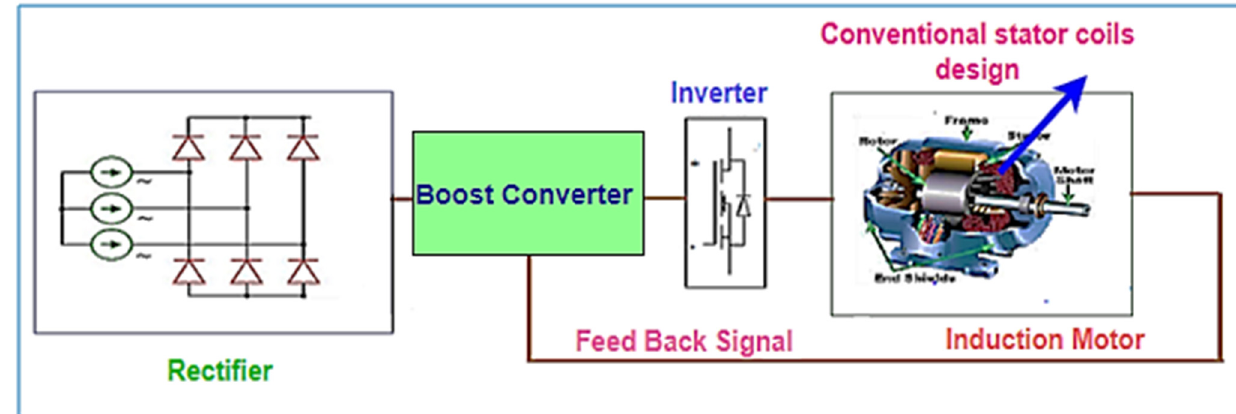
Figure 1. Controlling technique of motor drive.